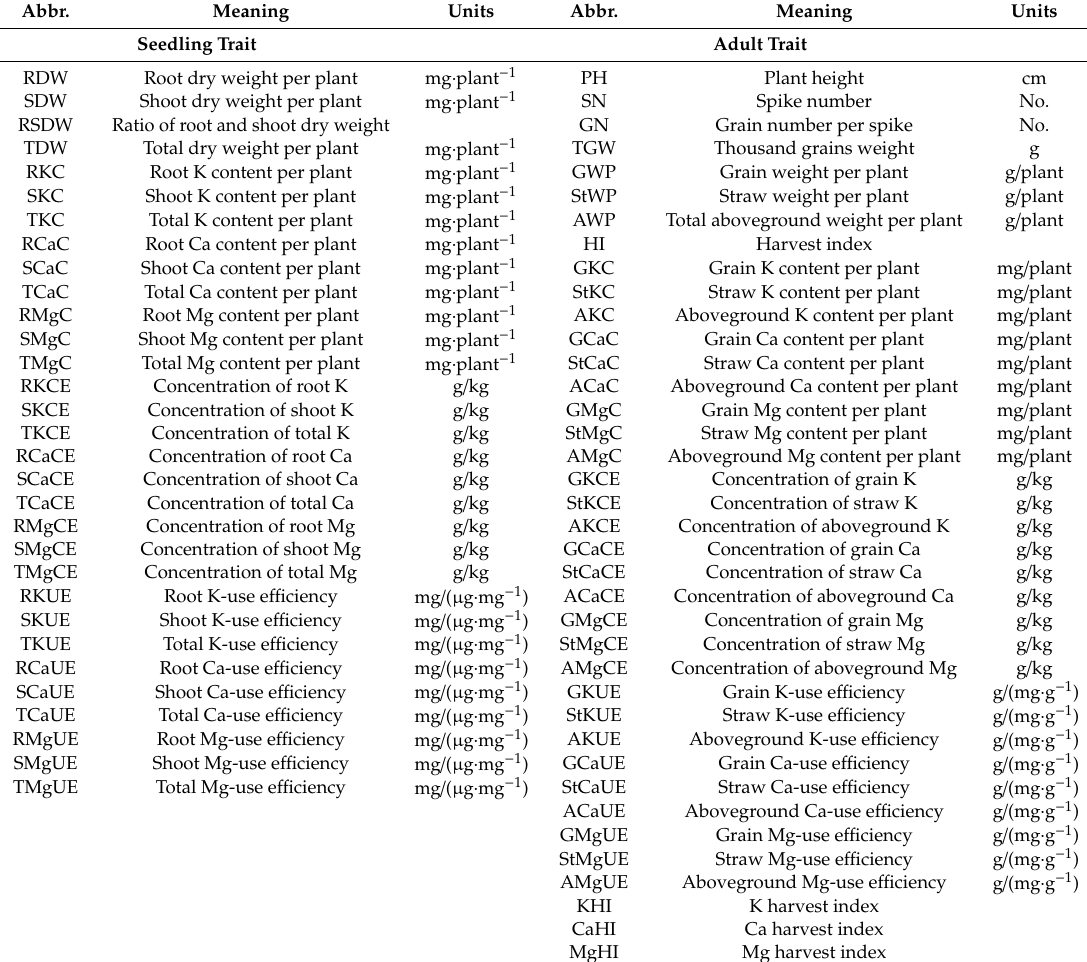
Table 1. Summary of investigated traits and their